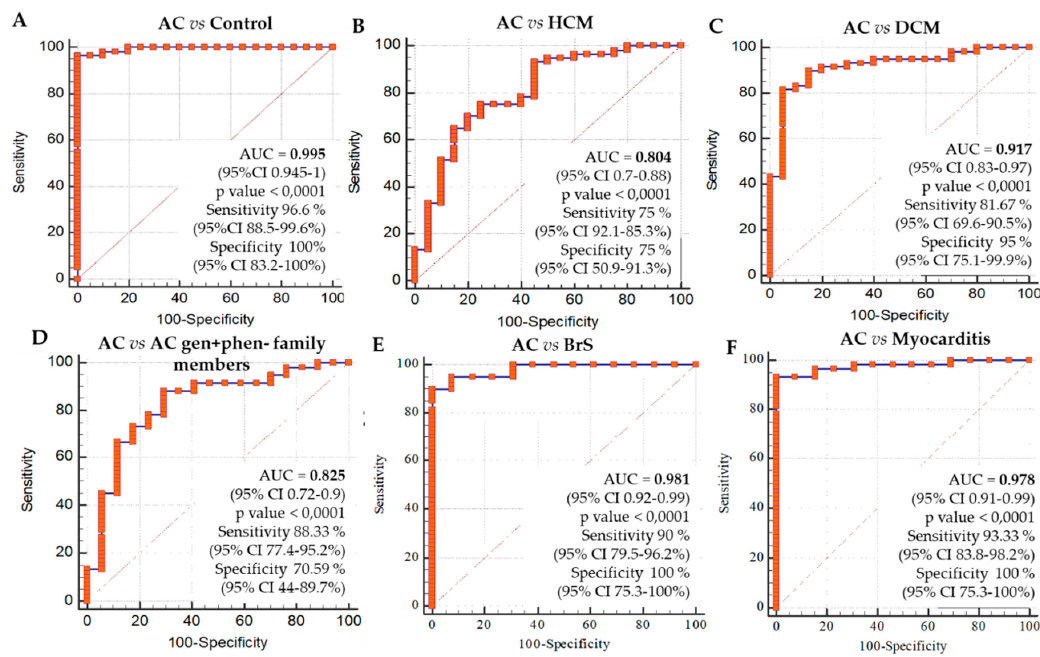
Figure 4. ROC plots, AUC values, p values, sensitivity and specificity of the 6-miRNA panel on: ( A ) – 70 AC vs. ctrl; ( B ) – 70 AC vs. DCM; ( C ) – 70 AC vs. HCM; ( D ) – 70 AC vs. AC gen+phen − family members, ( E ) – 70 AC vs. BrS; ( F ) – 70 AC vs myocarditis.